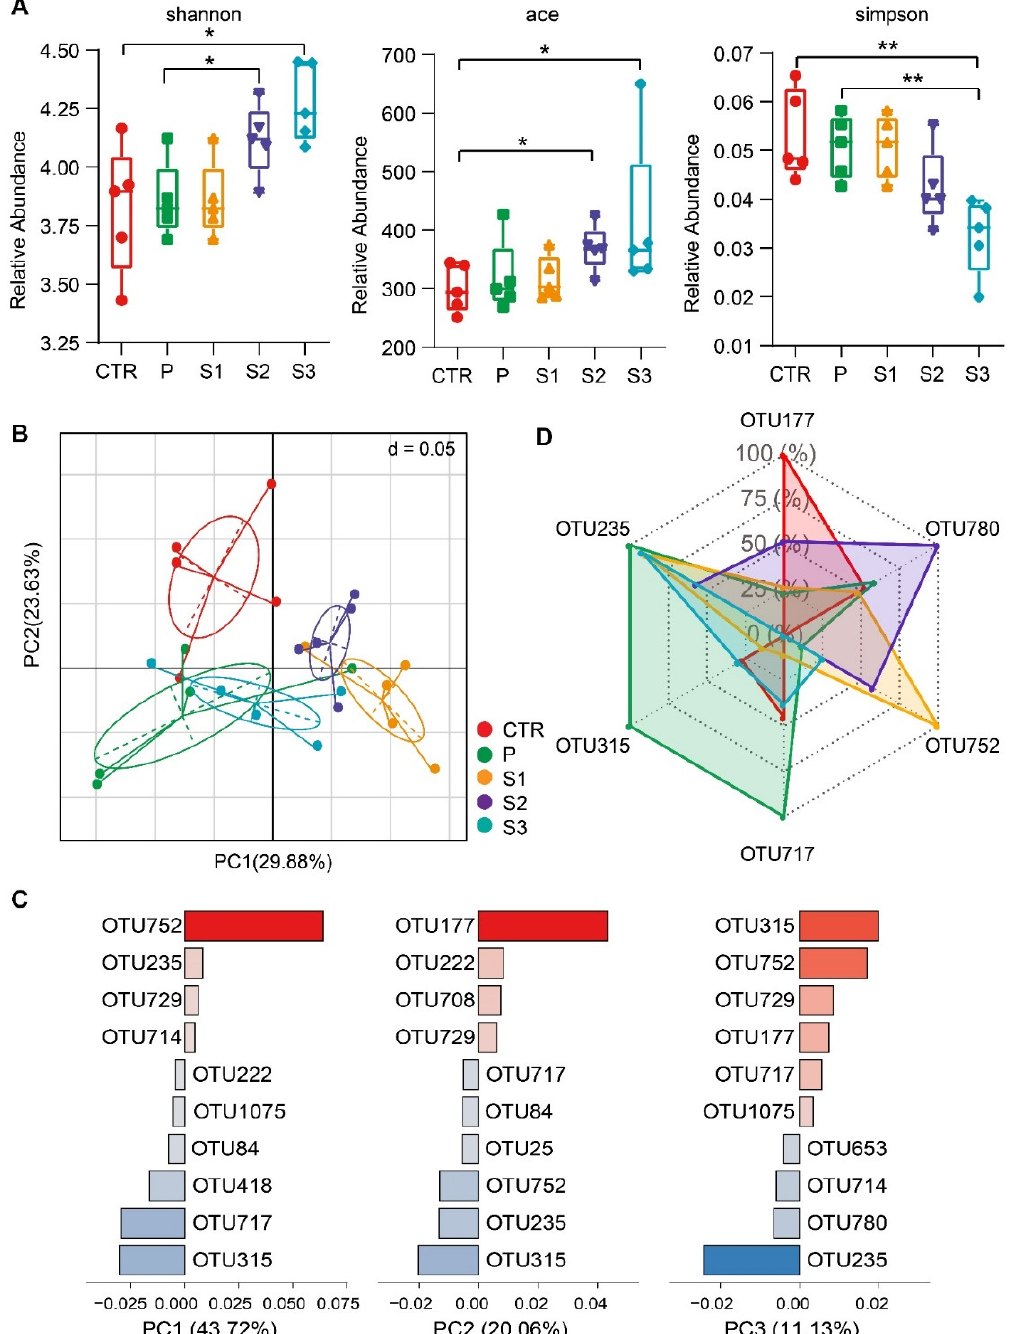
Figure 2. Alterations of the α -diversity and β -diversity in microflora of mice after oral supplement with JP. ( A ) Microbial alpha diversity shown in different indices: Shannon, Ace, and Simpson indices. ( B ) β -diversity analysis of microflora using principal component analysis (PCA) based on OTUs. ( C ) The contribution of key OTUs with the greatest impact on PCA clustering. ( D ) Radar chart of the key OTUs in different groups. * p < 0.05, ** p < 0.01.